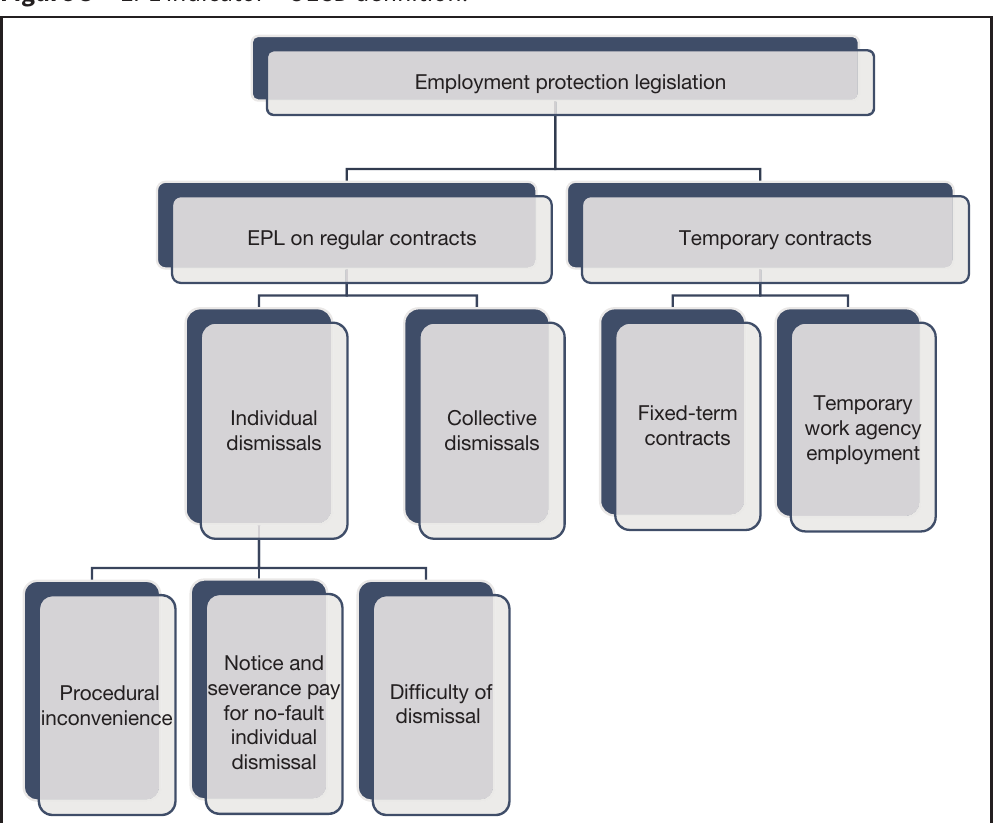
Employment protection